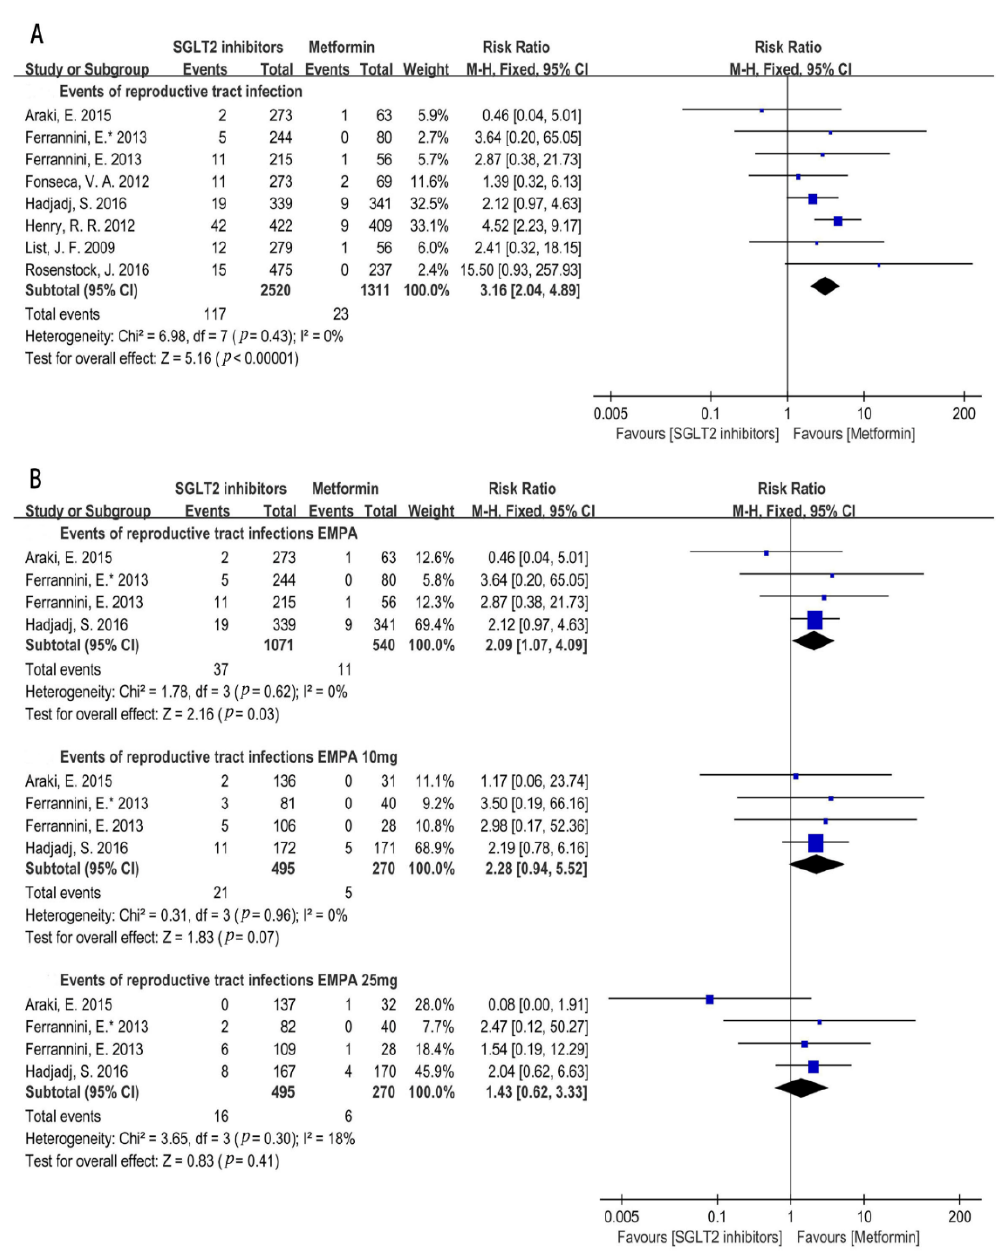
analysis of an RTI for dapagliflozin, canagliflozin, and ipragliflozin was not performed due to the lack of included literature.